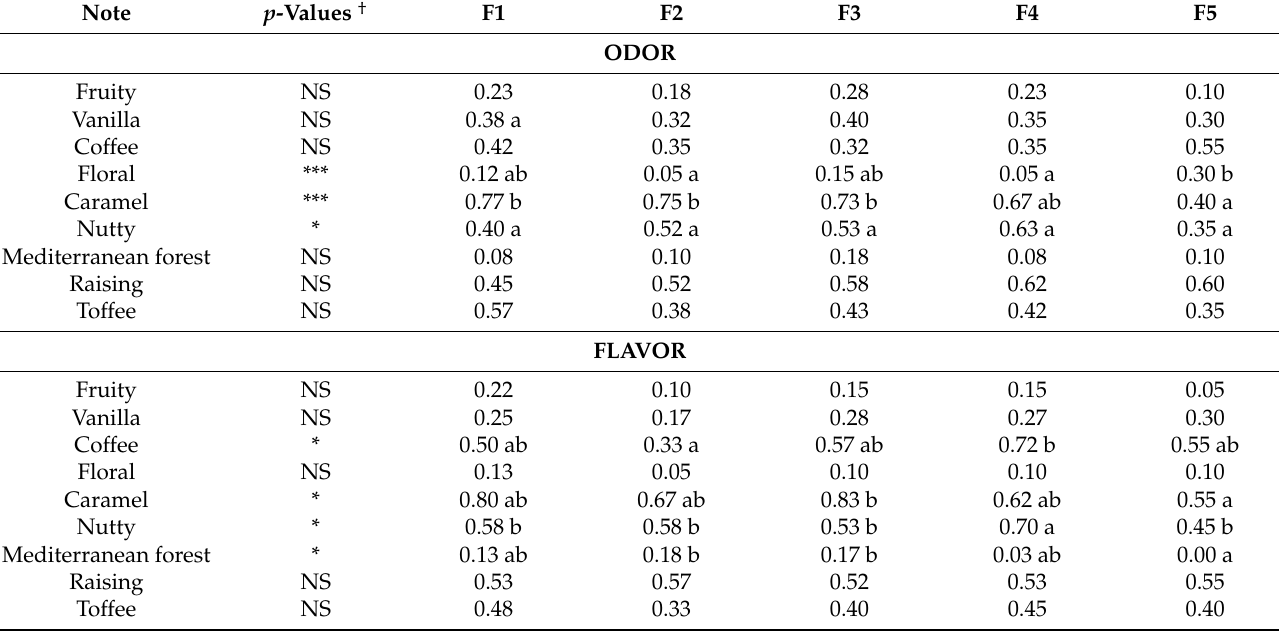
Table 3. Results of the Cochran’s Q test for each note used in the CATA